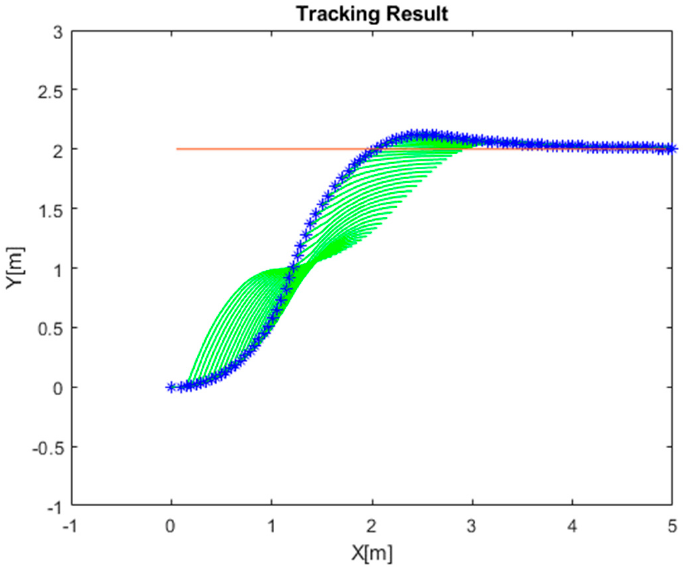
Figure 5. Line path tracking with manually tuned MPC parameters.